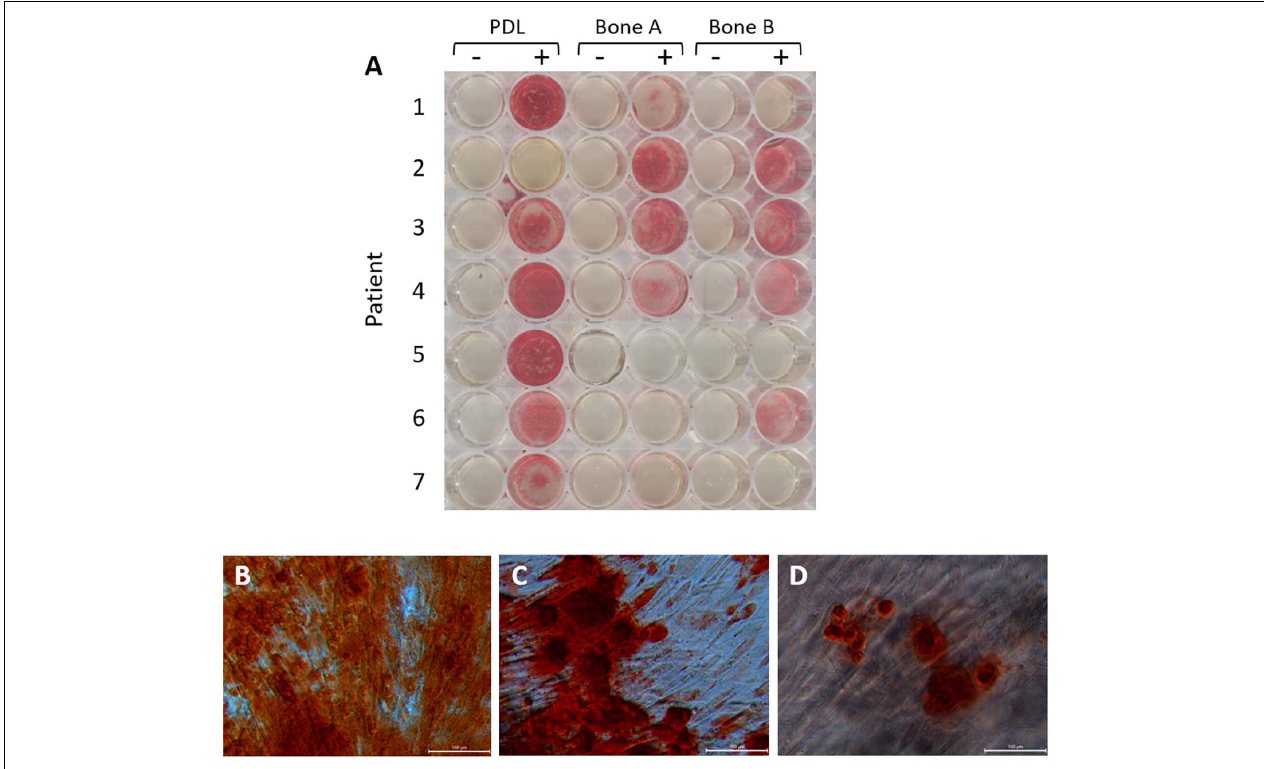
FIGURE 6 | Alizarin red staining after 21 days of osteogenic culture. (A) Wells without osteogenic medium (–) and with osteogenic medium (+) for PDL, bone A and bone B from 7 patients. Microscopic images of (B) PDL+, (C) Bone A+, (D) bone B+ from patient 1. Bar = 100 µ